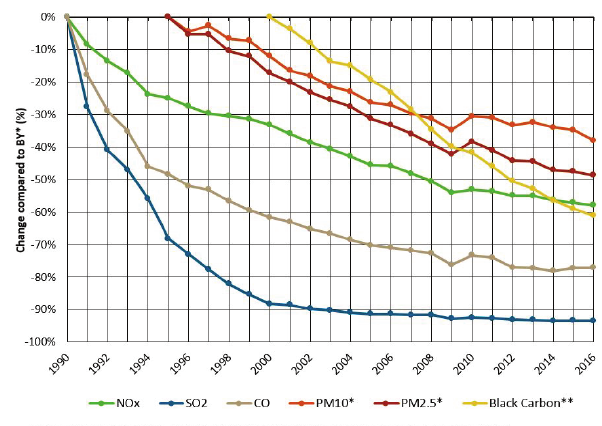
Figure 1: Air pollutants and emission trends (Source: German Emission Inventory